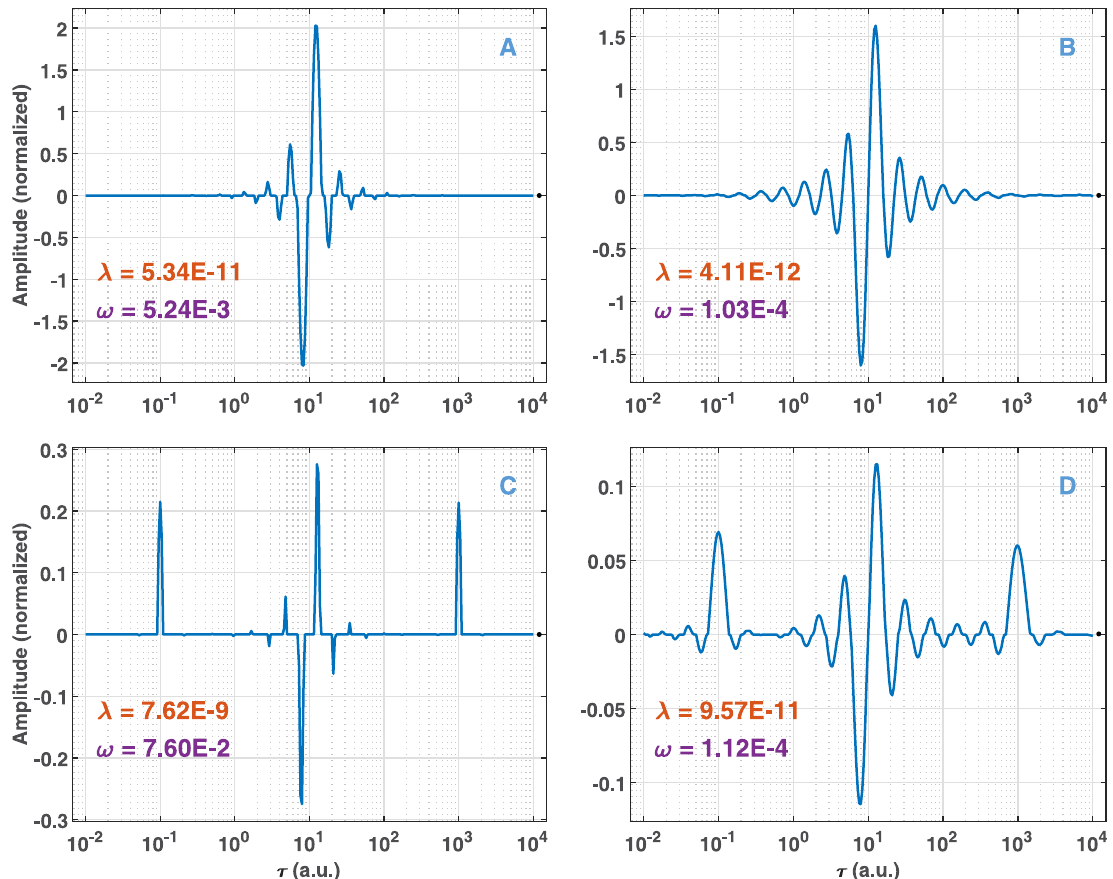
Fig 12. Solution of the GENP obtained from data described by formula (14) at low noise. For (A) and (C), model selection was carried out by RCV( n ), while for (B) and (D) by 10-fold CV. For (A) and (B), the value of A in the formula is 0, while for (C) and (D) its value is v 20. τ 1 = 10 1 , τ 2 = 10 − 1 , τ 3 = 10 3 . Noise level: σ rel = 10 − 7 . λ and ω are the hyperparameters found by the BO